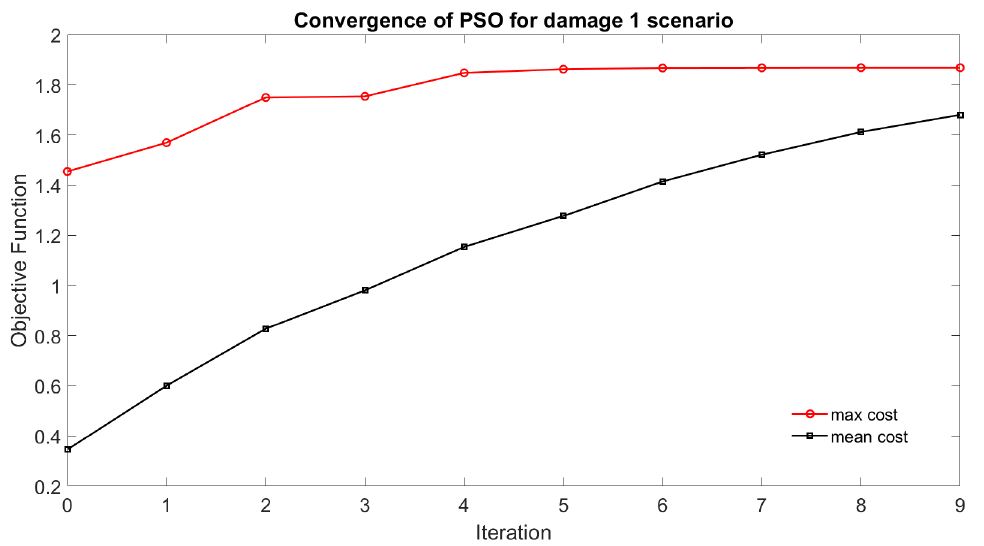
Figure 5. Convergence of the PSO to global